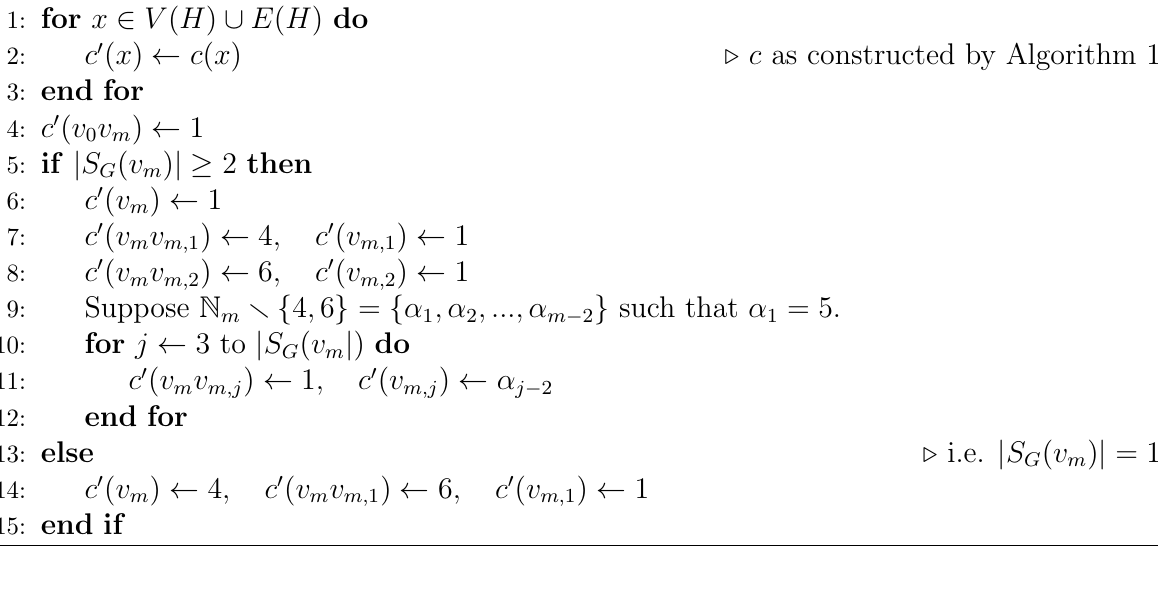
Algorithm 2 Constructing a total set m -coloring c for a graph G as in Corollary 3.2